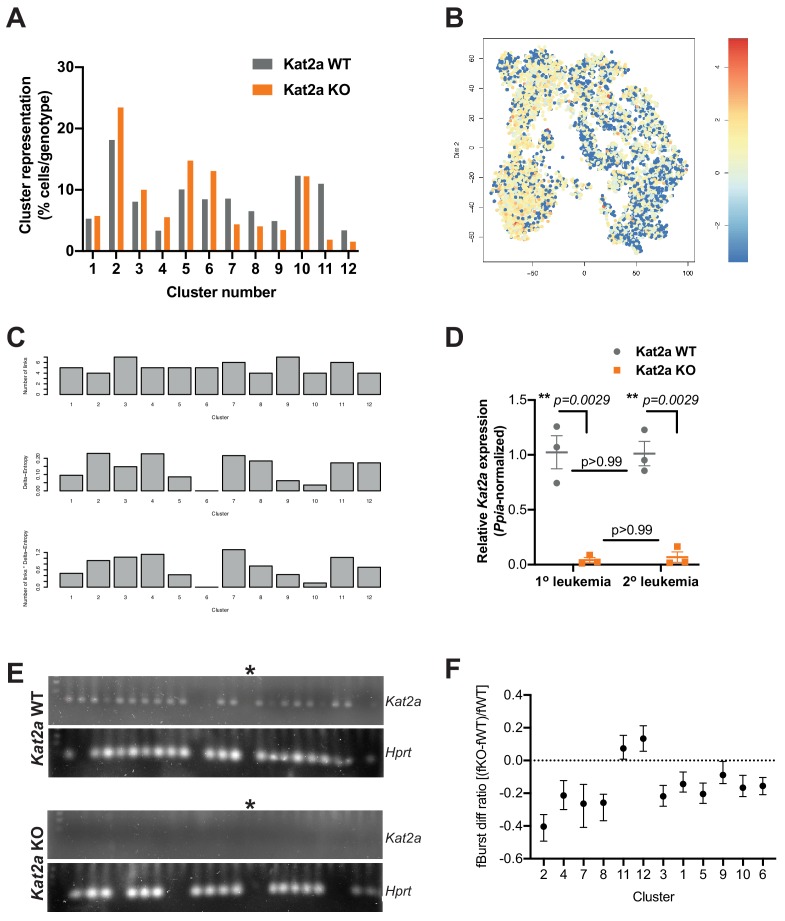
Kat2a WT and KO MLL-AF9 primary leukemias have distinct cluster composition and organization.(A) Relative representation of Kat2a WT and KO cells in RACE-ID clusters of primary MLL-AF9 leukemia. (B) Expression of an MLL-associated self-renewal gene signature in individual cells along the global MLL-AF9 STEM-ID pseudo-time trajectory. Trajectory representation as in Figure 4A, with both genotypes in the same plot. Gene signature defined as per the representation of gene set GCM_MLL (MSigDB) in the Robust geneset. (C) STEM-ID parameters of connectivity (top), entropy (middle) and stemness score (bottom) in MLL-AF9 primary leukemia clusters represented in Figure 4B. The cluster stemness score is the product of the cluster entropy measure and number of links for the cluster in the network; cluster seven has the highest stemness score. (D) Quantitative RT-PCR analysis of Kat2a expression in primary (as per Figure 2B) and secondary MLL-AF9 leukemias of Kat2a WT and Kat2a KO genotypes. Primers and probe used assay exons 6 and 7, within the excised genomic region. N = 3 individual leukemias per genotype and time-point; mean ± SEM; 2-tailed t-test at significant p<0.05. (E) Representative gel electrophoresis of nested single-cell RT-PCR analysis of Kat2a expression in Lin-Kit+Sca-CD16/32+ cells obtained from secondary MLL-AF9 leukemias initiated with Kat2a WT (top) or KO (bottom) cells. Total = 88 Lin-Kit+Sca-CD16/32+ cells/genotype, two different leukemias each; detection frequency of Hprt in duplex was 83% (Kat2a WT) and 76% (Kat2a KO); * no-template control lane. We analyzed a total of 176 cells, including Lin-Kit+Sca-CD16/32+ and Lin-Kit+ cells, and observed 9% Kat2a-expressing Hprt+ KO cells (84% in WT), all of which in the Kit- population. (F) Differential burst frequency between Kat2a KO and WT primary MLL-AF9 leukemia cells in individual clusters along the STEM-ID trajectory presented in the main text Figure 4B.